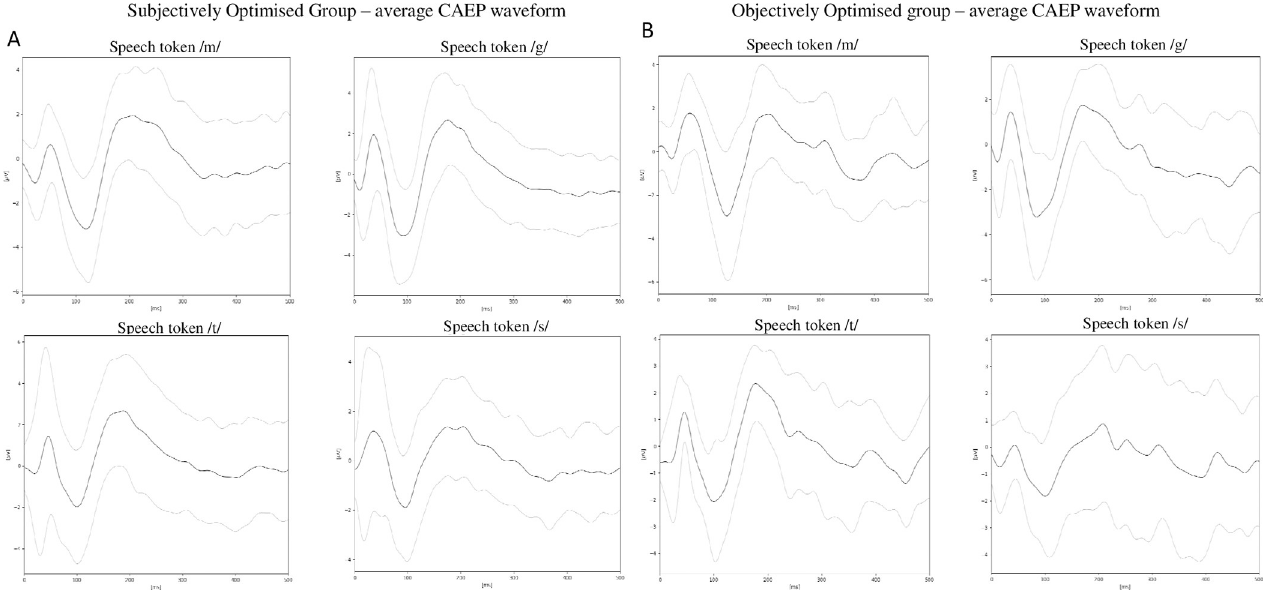
Fig 3. Average waveforms for the four speech tokens for the subjectively optimised and objectively optimised groups. The black line represents the group average waveform. The light grey lines represent group mean ± standard deviation.